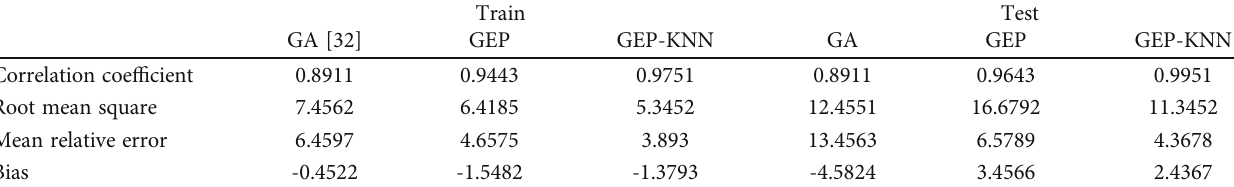
Table 3: Evaluation of metric